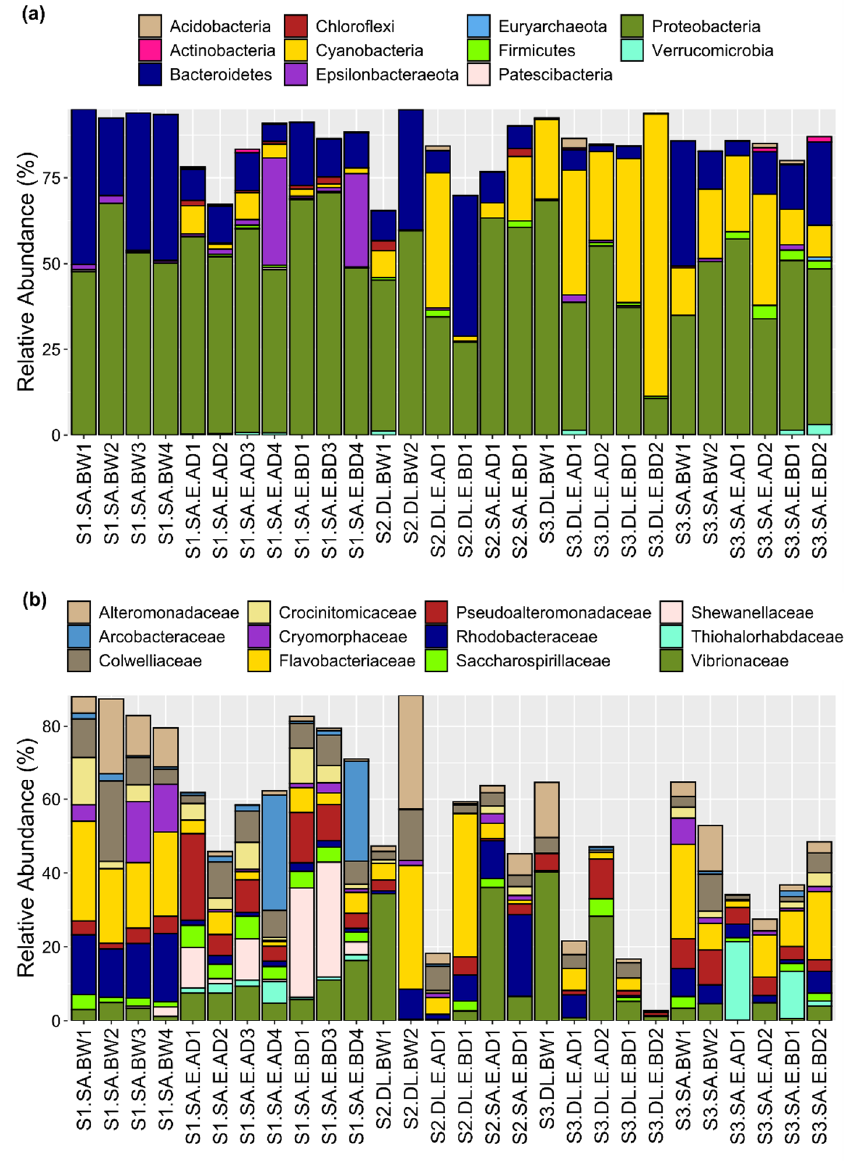
Figure 3. The relative abundance of the 11 phyla ( a ) and 12 families ( b ) across egg and water samples. The relative proportions of phyla and families (in % in relation to the total profiled microbiome) were plotted using the ggplot2 R package. Information about the sample labels is presented in the legend of Figure 1.